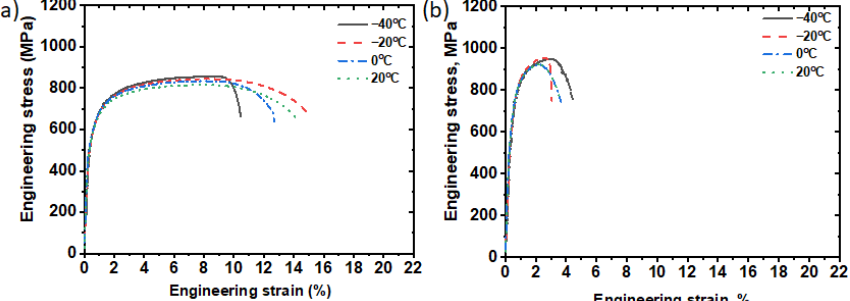
Figure 6. Engineering stress – strain curves of ( a ) DP800 – and ( b ) DP1000 – welded joints at different deformation temperatures.